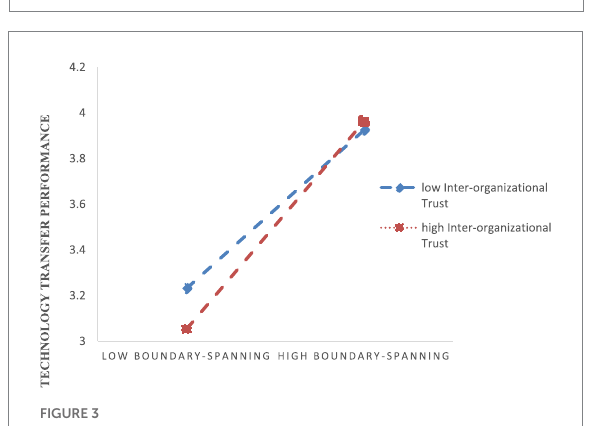
FIGURE 2 The figure of the moderator effect of technology potential gap.